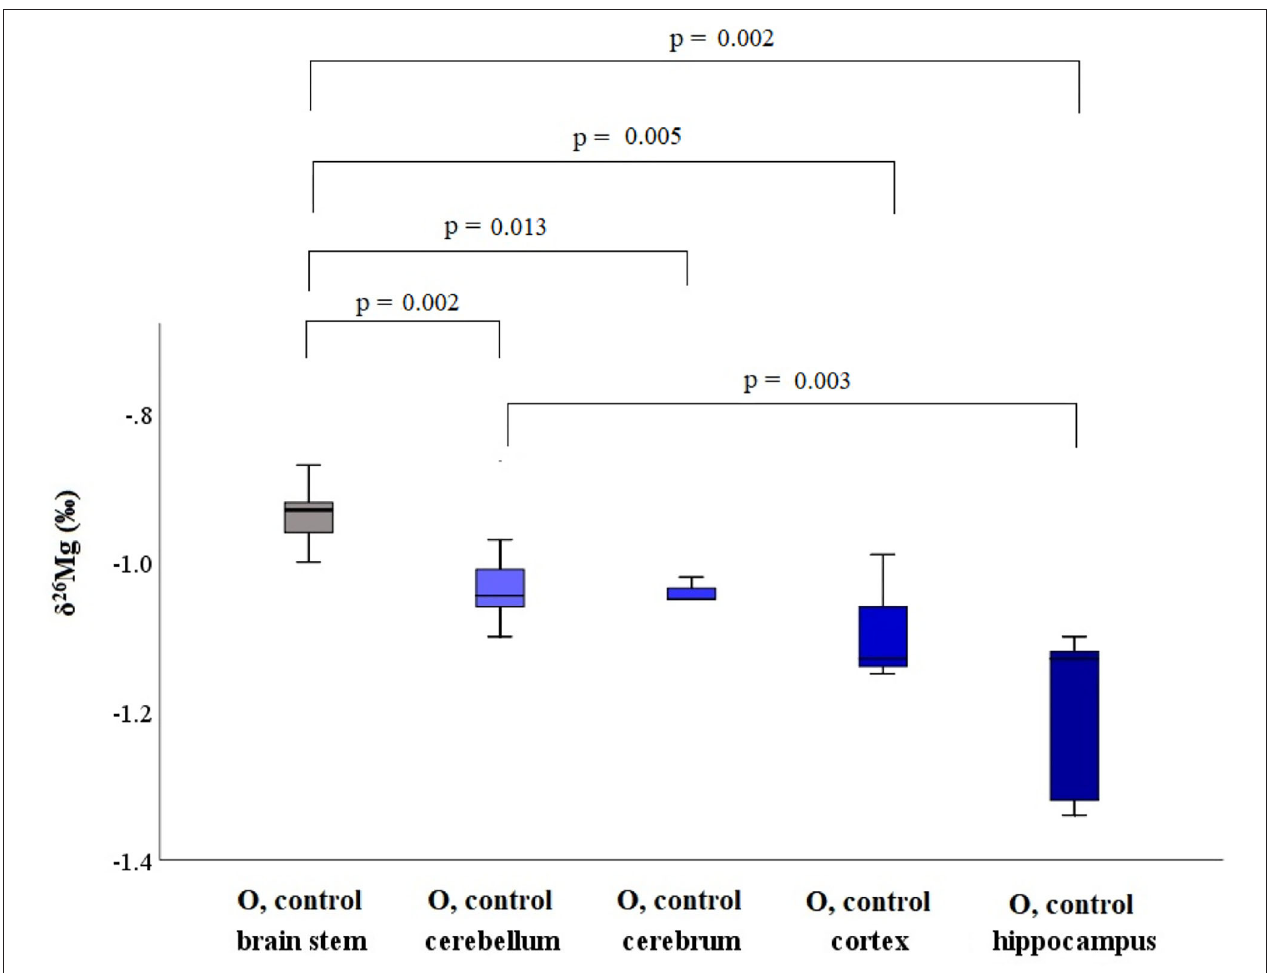
FIGURE 4 | Boxplots for the Mg isotopic composition in different brain regions for aged controls. These box plots compile the median, quartiles and extreme